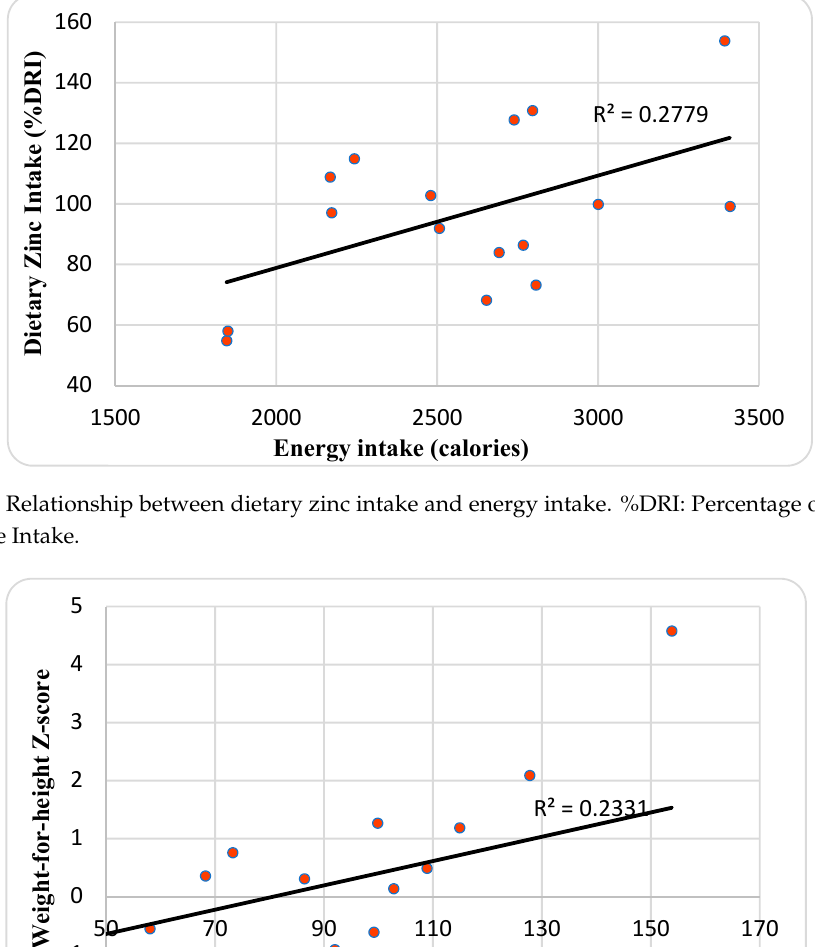
Figure 3. Relationship between serum zinc concentration and weight ‐ for ‐ height Z ‐ score.